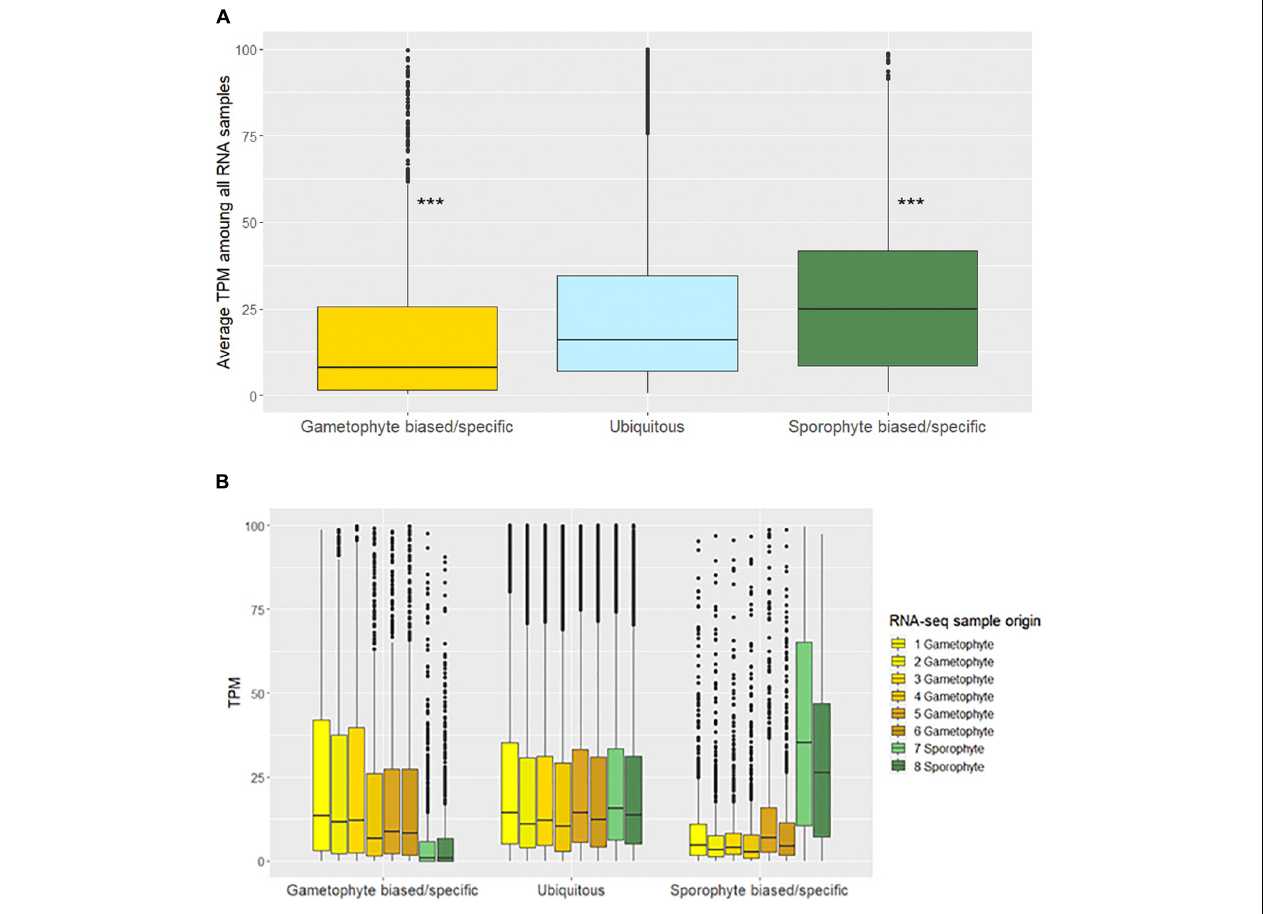
FIGURE 2 | (A) Average transcripts per million (TPM) for each life stage among all RNA samples. (pairwise Wilcoxon test; *** p -value < 0.001). (B) TPM for each RNA-seq sample separated into each life stage.